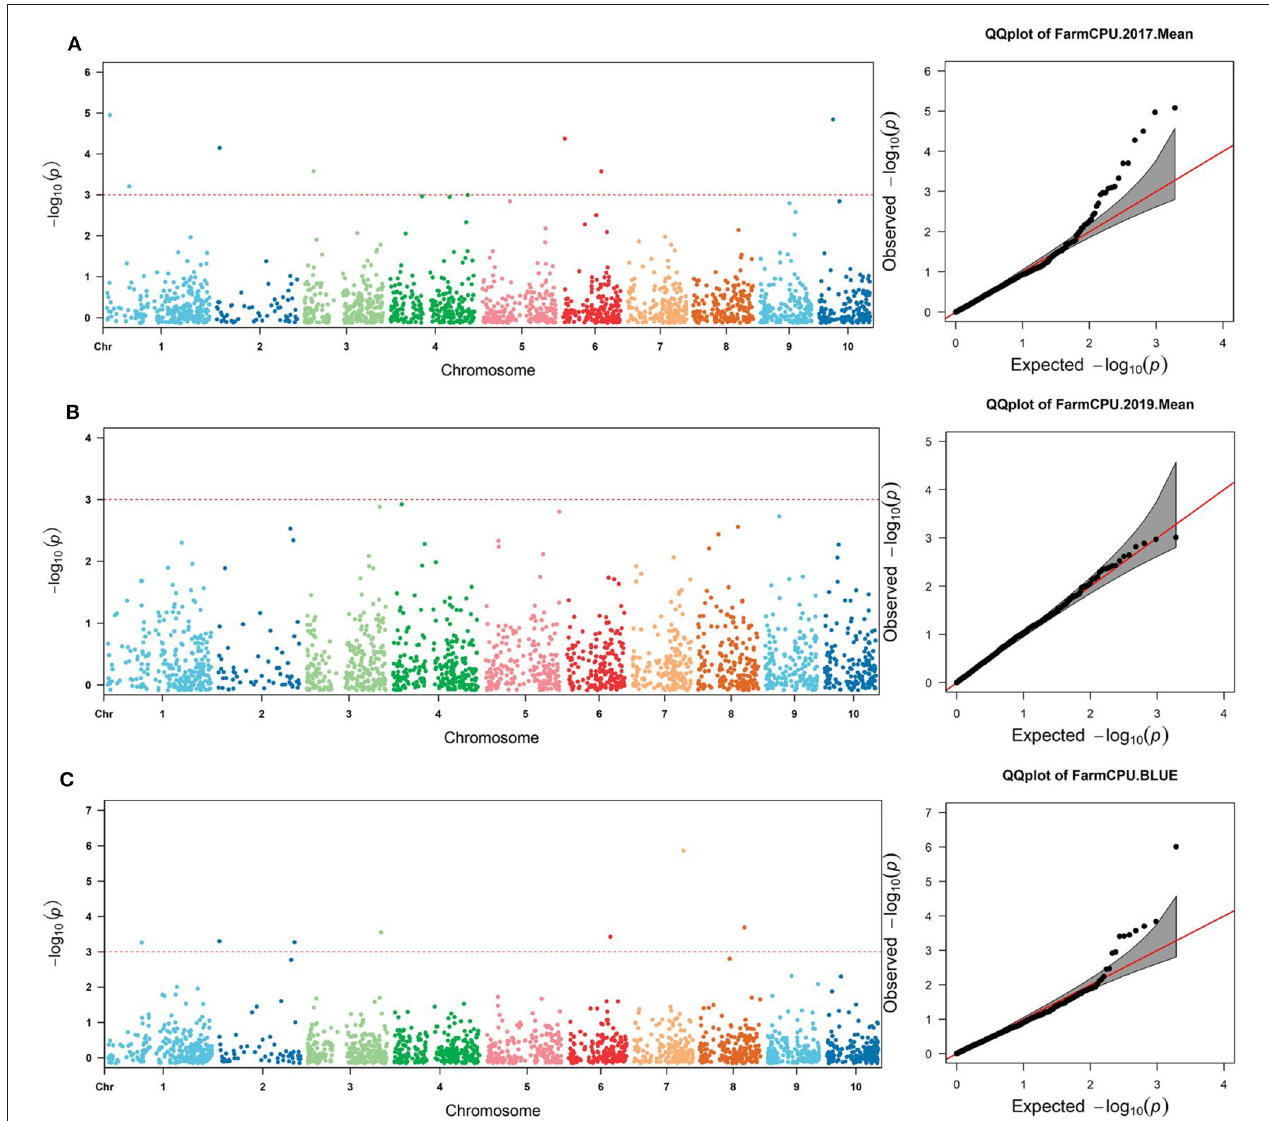
FIGURE 4 | Manhattan plots and (Q–Q) plots of 165 inbred lines resistant to stalk rot [ (A) 2017; (B) 2019; (C) : BLUE].